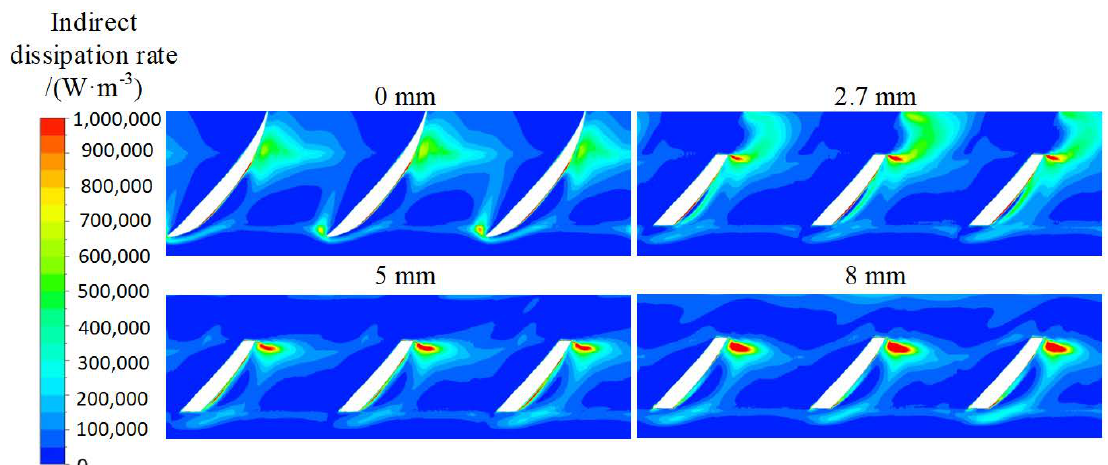
Figure 13. Distribution of the indirect dissipation rate at Span = 0.015 in the impeller passage with varying root clearances ( R t = 0 mm, 2.7 mm, 5 mm 8 mm; Q = 1.0 Q des